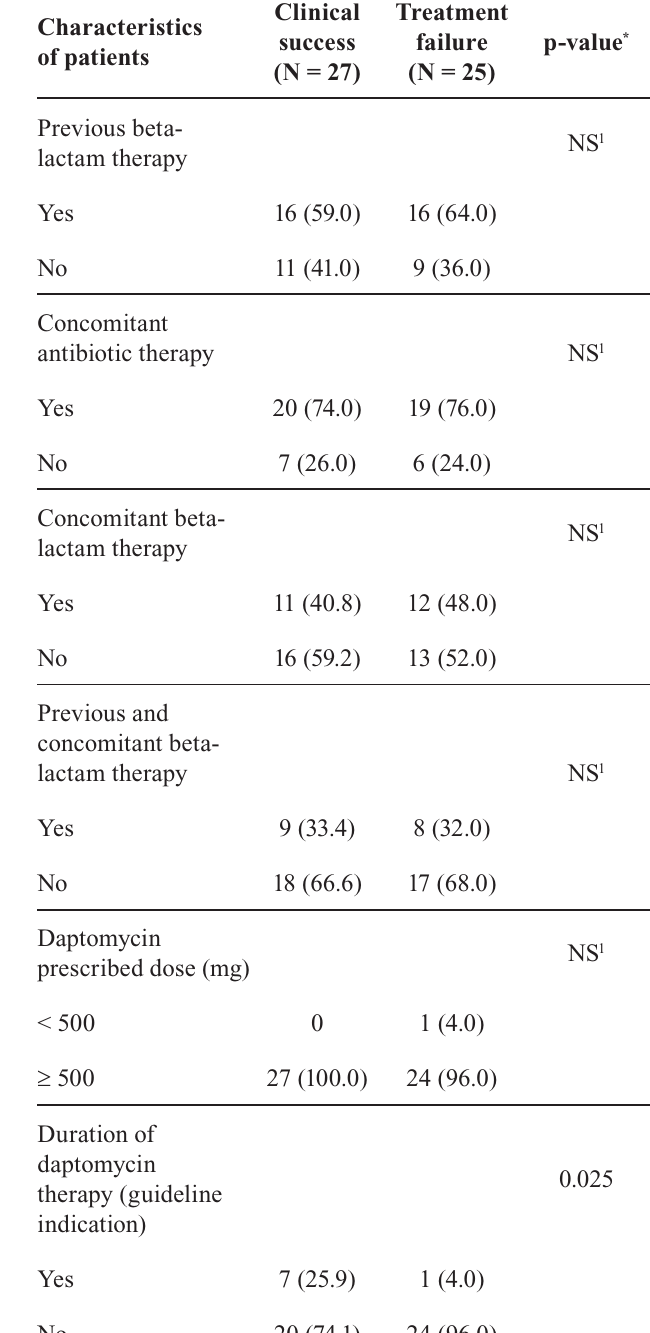
TABLE I - D emographic and clinical characteristics of the 52 patients undergoing daptomycin therapy. Brazil, 2010–14